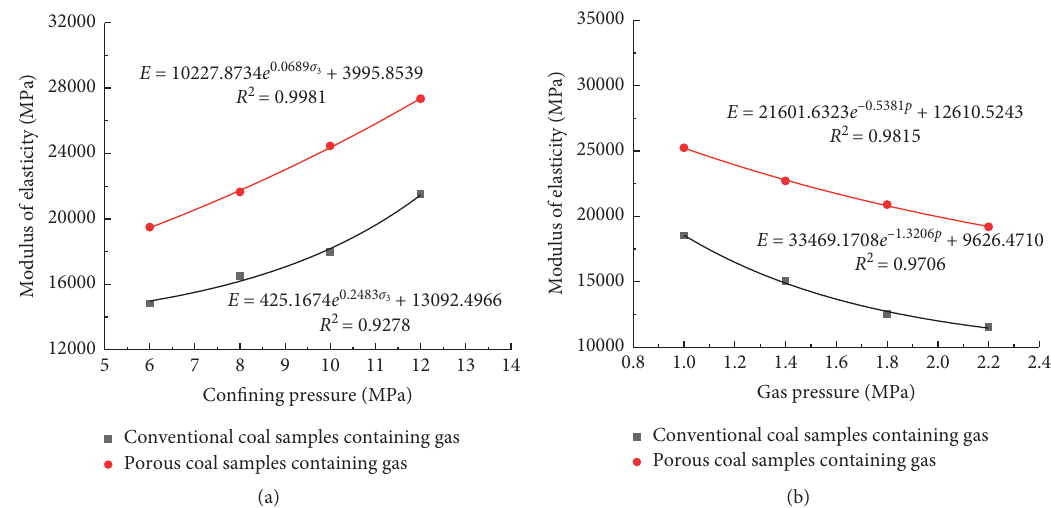
Figure 4: The variation of elastic modulus of porous and conventional gas-bearing coal samples with confining pressure or gas pressure: (a) variation with confining pressure; (b) variation with gas pressure